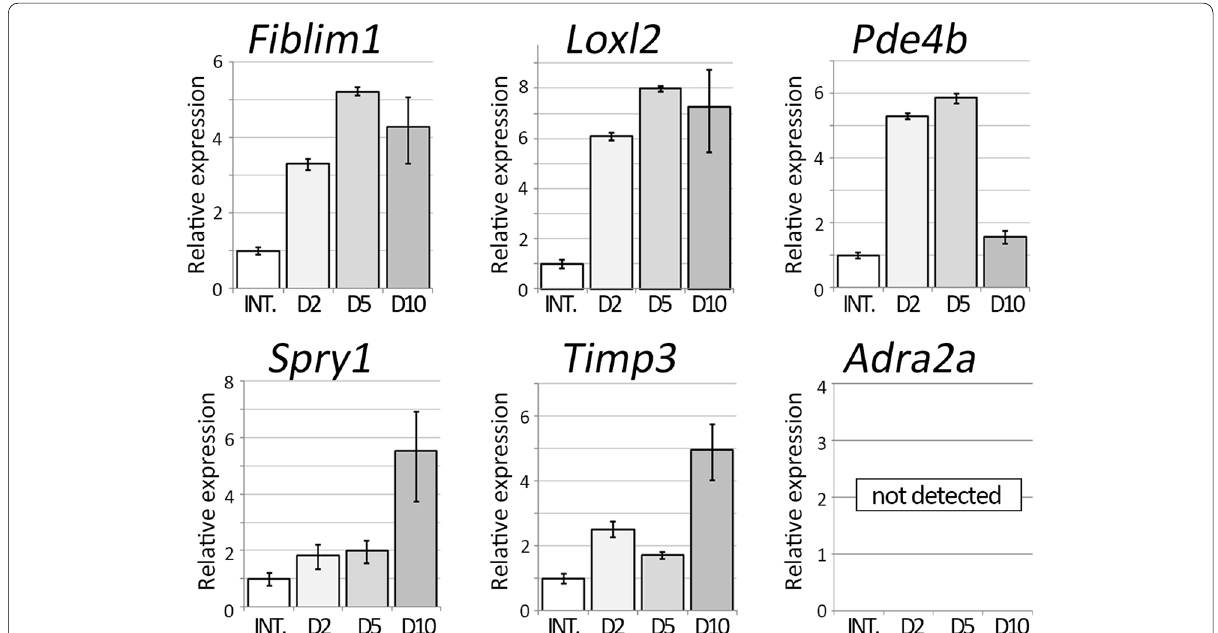
Fig. 4 Time course of gene expression in axolotl regenerating limbs. The genes selected from the comparative analysis between the mouse and newt cells were investigated in axolotl blastemas. The quantitative RT-PCR to the samples, which were prepared from blastemas at different time points, was performed. INT. intact limbs. D2 2 days after limb = =